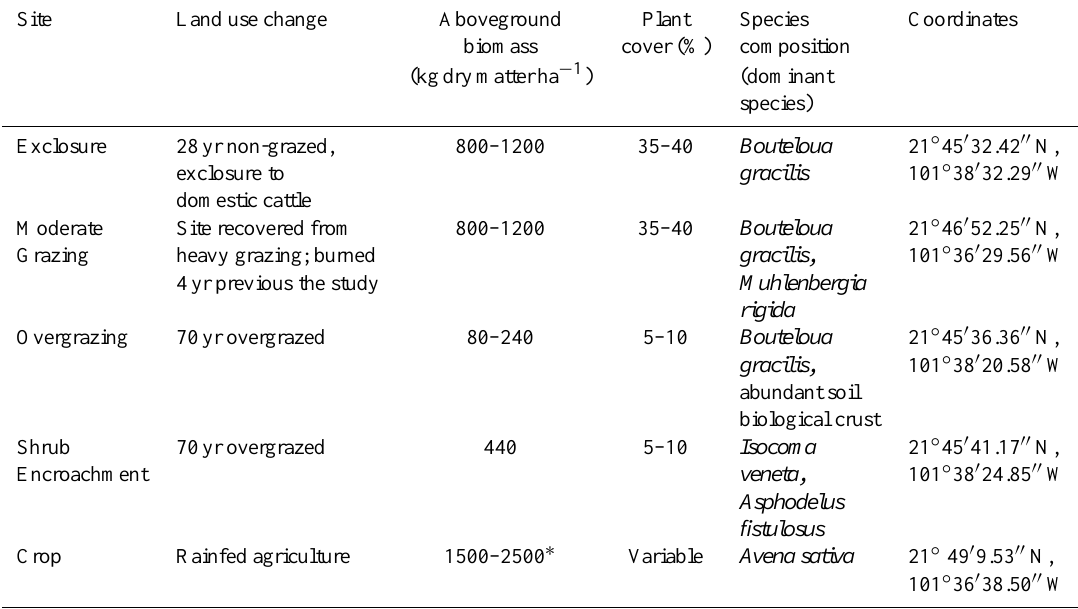
Table 1. Shortgrass steppe characteristics of the study sites in the sub-province Llanos de Ojuelos, located in the northeast part of Jalisco State,